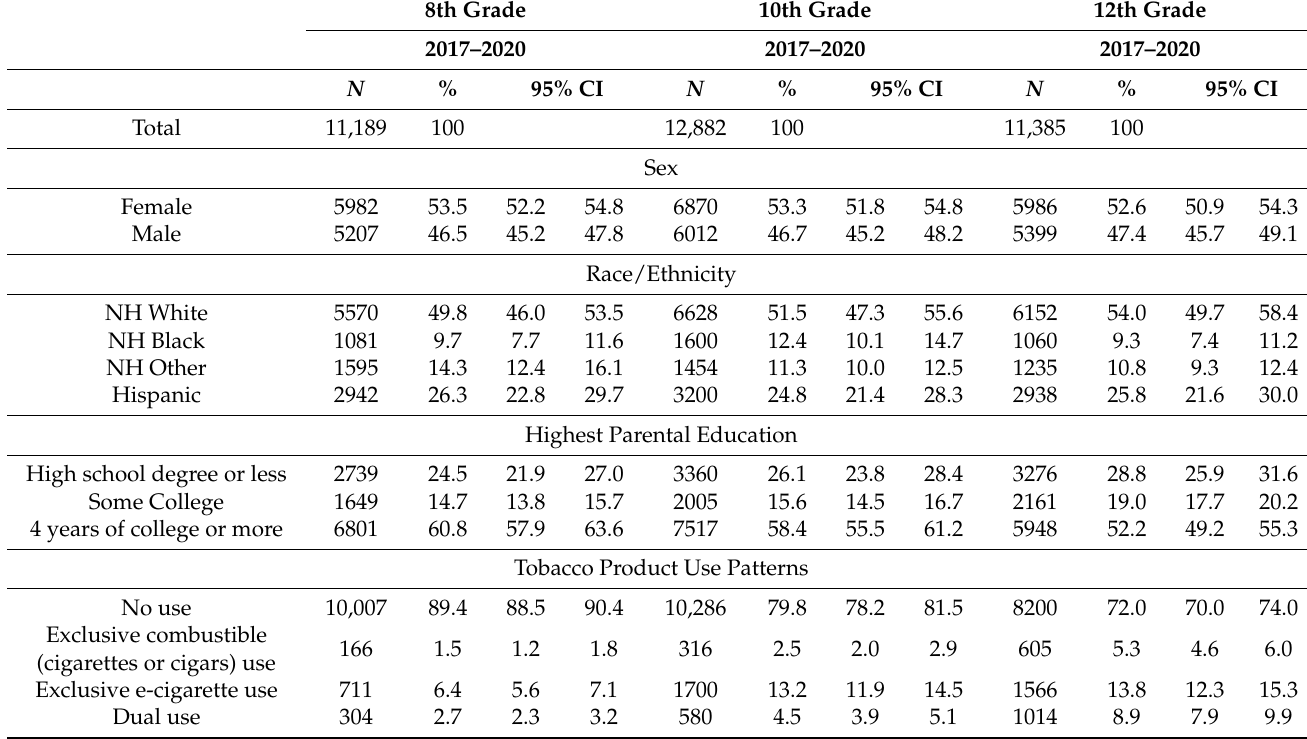
Table 1. Descriptive statistics of study samples of exclusive and dual use of combustibles (cigarette and cigars) and e-cigarettes: Monitoring the Future Surveys 2017 to